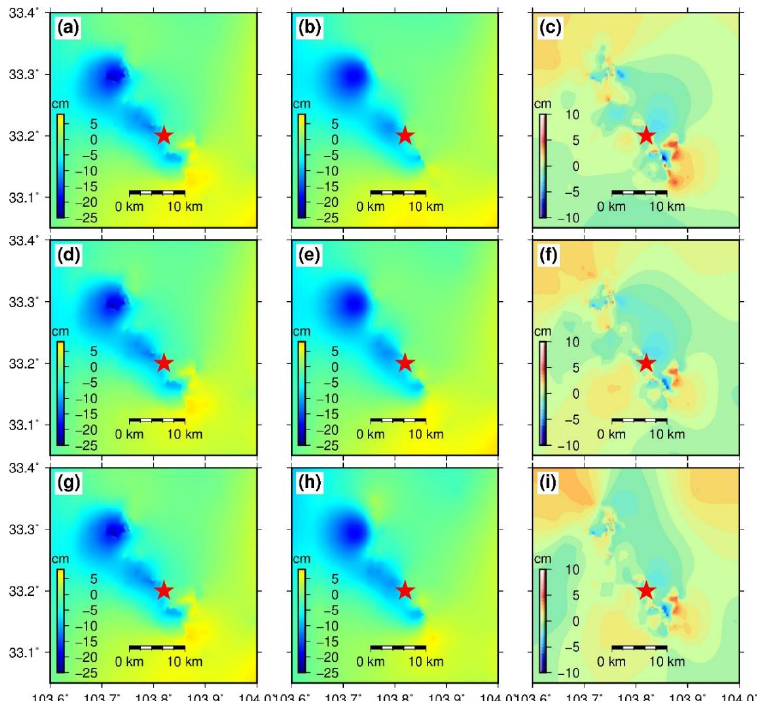
Figure 3. Comparison between interferometric synthetic aperture radar (InSAR) observations and predictions from the three test models. ( a , d , g ) Coseismic line-of-sight (LOS) deformation. Simulated LOS deformation from the ( b ) one-fault model, ( e ) two-fault model, and ( h ) three-fault model. ( c , f , i ) Residuals. Red star represents the epicenter of the 2017 Jiuzhaigou earthquake from the CEA-IGP.